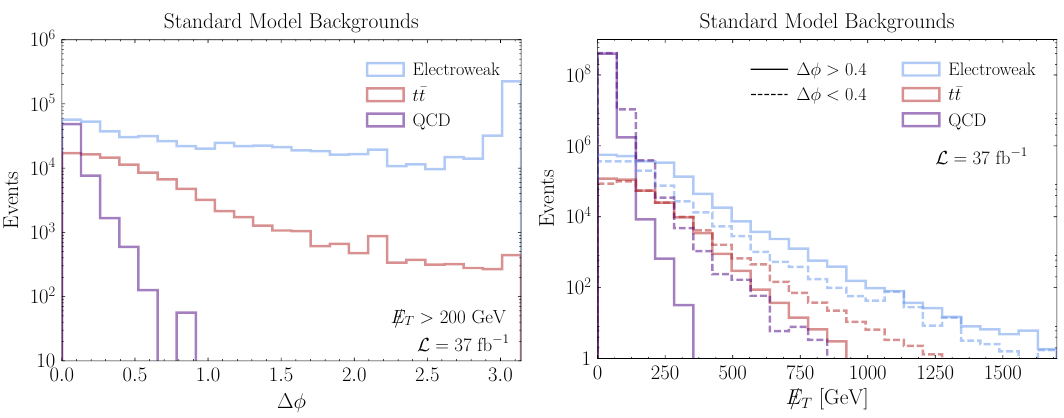
Figure 6 . (Left) (cid:1) (cid:30) distributions for the Standard Model backgrounds. (Right) Missing energy distributions for the Standard Model backgrounds with a cut of (cid:1) (cid:30) > 0 : 4 (solid) and (cid:1) (cid:30) < 0 : 4 (dashed). No trigger or preselection cuts are applied, except for the requirement that (cid:30) E T > 200 GeV in the left